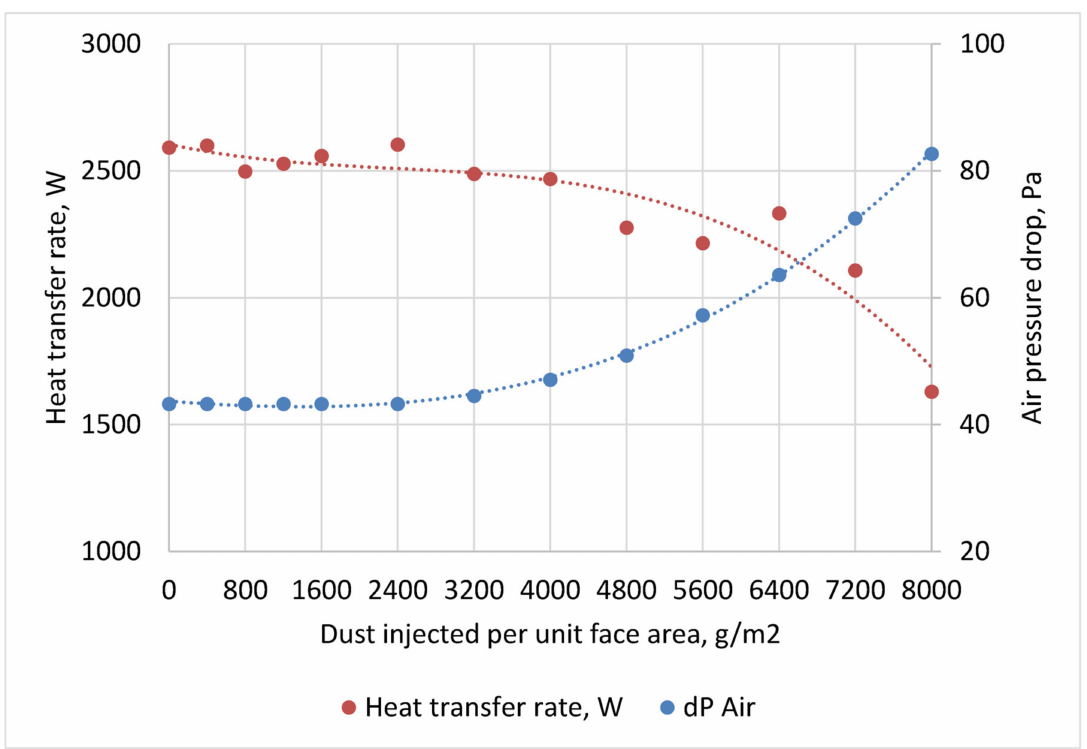
Figure 10. Influence of fouling evolution on heat transfer and pressure